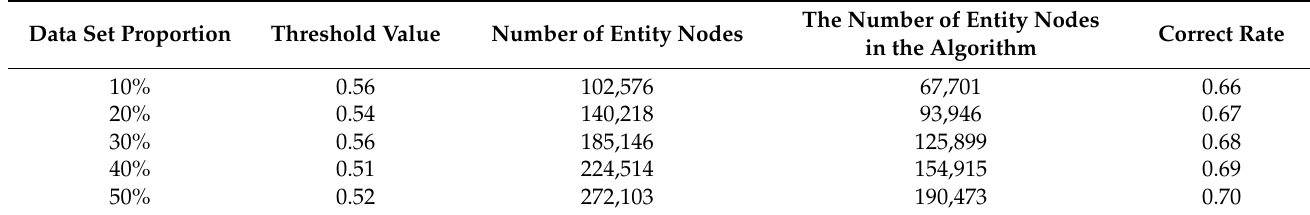
Table 2. Correct rate of the